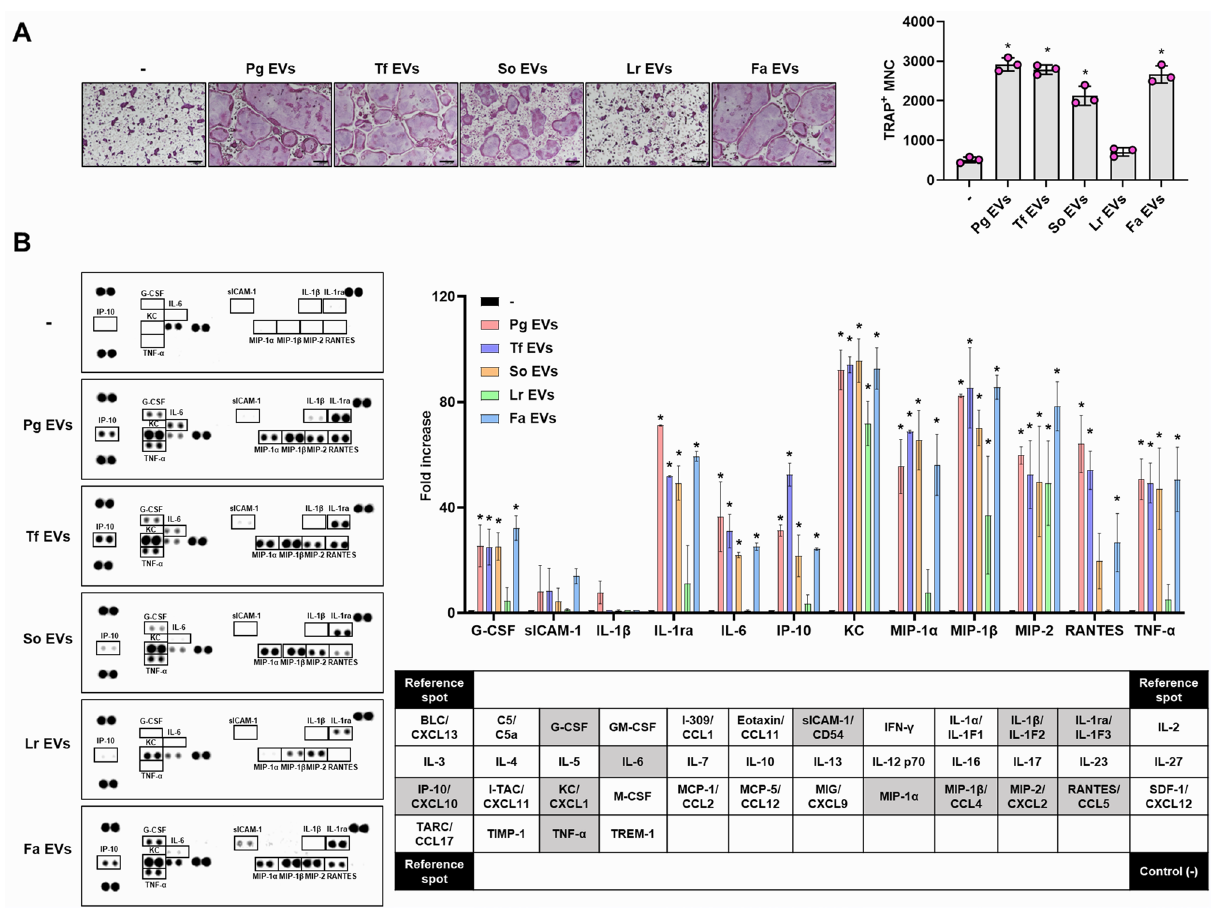
Figure 2. Effects of bacterial EVs on osteoclast differentiation and activation. ( A ) Osteoclast precursors were stimulated with bacterial EVs (10 μg/ml EV protein) in the presence of M-CSF (30 ng/ml) for 3 days. The mature osteoclasts were stained with TRAP, and representative images from triplicate samples are shown (left panel, scale bar: 200 μm). The number of TRAP + mature osteoclasts was counted (right panel). The experiments were performed at least three times independently. The graphs show the mean values ± standard deviations of a representative experiment. ( B ) Osteoclast precursors were stimulated with bacterial EVs (10 μg/ml EV protein) in the presence of M-CSF (30 ng/ml) for 24 h. Then, cytokines in the supernatants were analysed using a Cytokine Array Kit. Dot intensity was measured by densitometry using Bio-Rad Image Lab software. The fold increase (right upper panel) of the treatment groups was determined by dividing the dot intensity value by that of nontreatment group. The graphs show the mean values ± standard deviations of two biological replicates. Statistical significance was determined by one-way ANOVA ( A ) or by two-way ANOVA ( B ). * P < 0.05 compared with the nontreatment group ( Immunostimulatory effects of oral bacterial EVs on osteoclast precursors. Osteoclasts are multinucleated giant cells that originated from haematopoietic lineage mononuclear cells. Local infection of periodontal pathogens can cause osteoclast differentiation and bone resorption 17 . Recently, we determined that EVs from the Gram-positive periodontal pathogen F. alocis efficiently induce osteoclast differentiation and activation 15 . We used Fa EVs as a positive control to induce osteoclast differentiation in further experiments in this study. To evaluate the osteoclastogenic potencies of EVs from Gram-negative periodontal pathogens (Pg EVs and Tf EVs), an oral commensal strain (So EVs), and a gut probiotic strain (Lr EVs), committed osteoclast precursors were stimulated with bacterial EVs (10 μg/ml) without RANKL. As shown in Fig. 2A, EVs from Pg EVs and Tf EVs remarkably induced osteoclast differentiation, similar to Fa EVs. Interestingly, So EVs also induced osteoclast differentiation. However, Lr EVs did not induce differentiation to mature osteoclasts. The osteoclastogenic potencies of EVs from mid-log phase were similar to those of EVs from 48 h culture superna- tants (Supplementary Fig. S1). Next, to identify the immunostimulatory effects of bacterial EVs on osteoclast precursors, we stimulated osteoclast precursors with each bacterial EV and analysed 40 cytokines in the culture supernatants using a cytokine array (Fig. 2B). Bacterial EVs, which have osteoclastogenic potencies (Pg EVs, Tf EVs, So EVs, and Fa EVs), increased the expression of G-CSF, IL-1ra, IL-6, IP-10, KC, MIP-1α, MIP-1β, MIP-2, RANTES and TNF-α in osteoclast precursors. Lr EVs increased the expression of KC, MIP-1β, and MIP-2, but did not induce major osteoclastogenic cytokines, such as TNF-α, IL-6, and IL-1β. These results indicate that